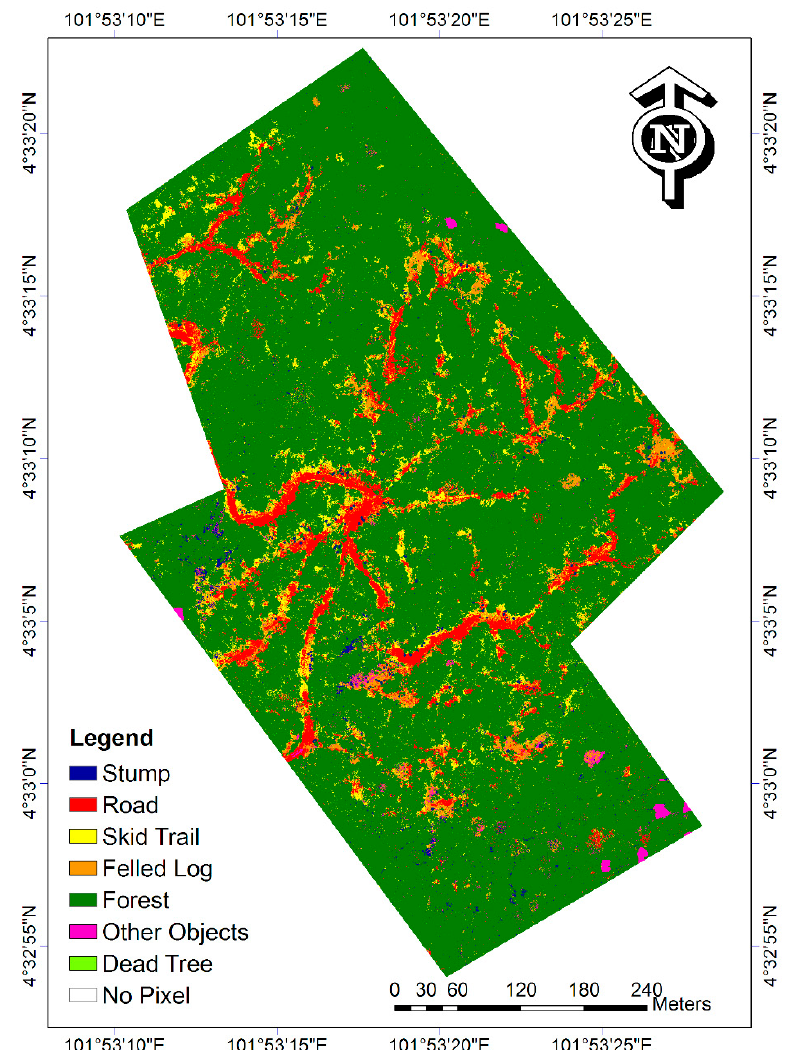
Figure 13. Classification map of selective logging indicators using SVM method.